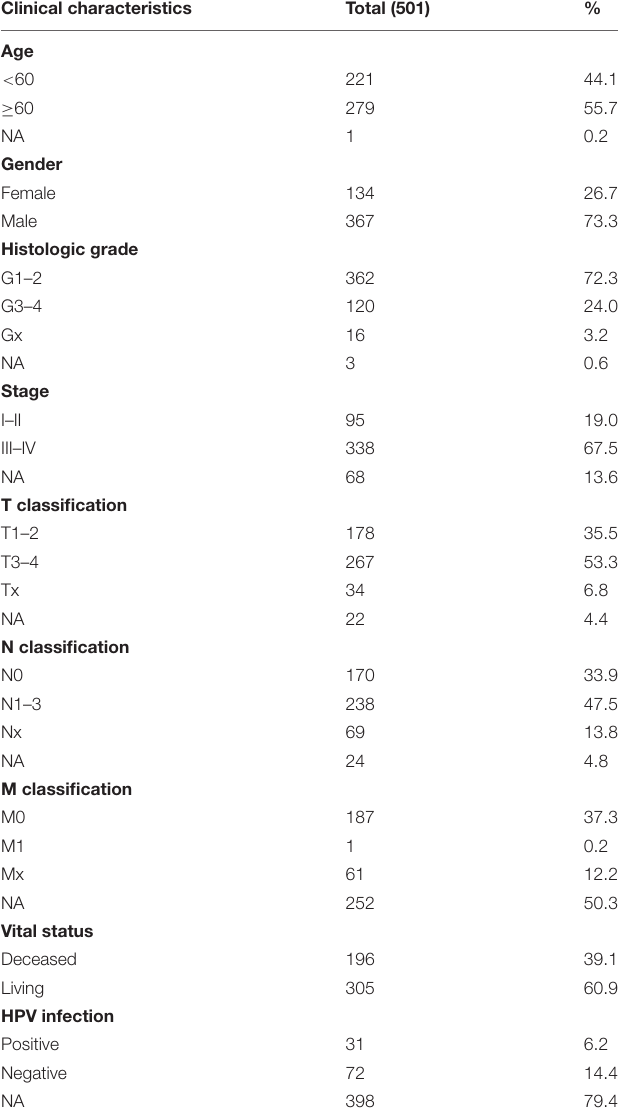
TABLE 1 | Clinical characteristics of TCGA HNSCCs patients ( n =